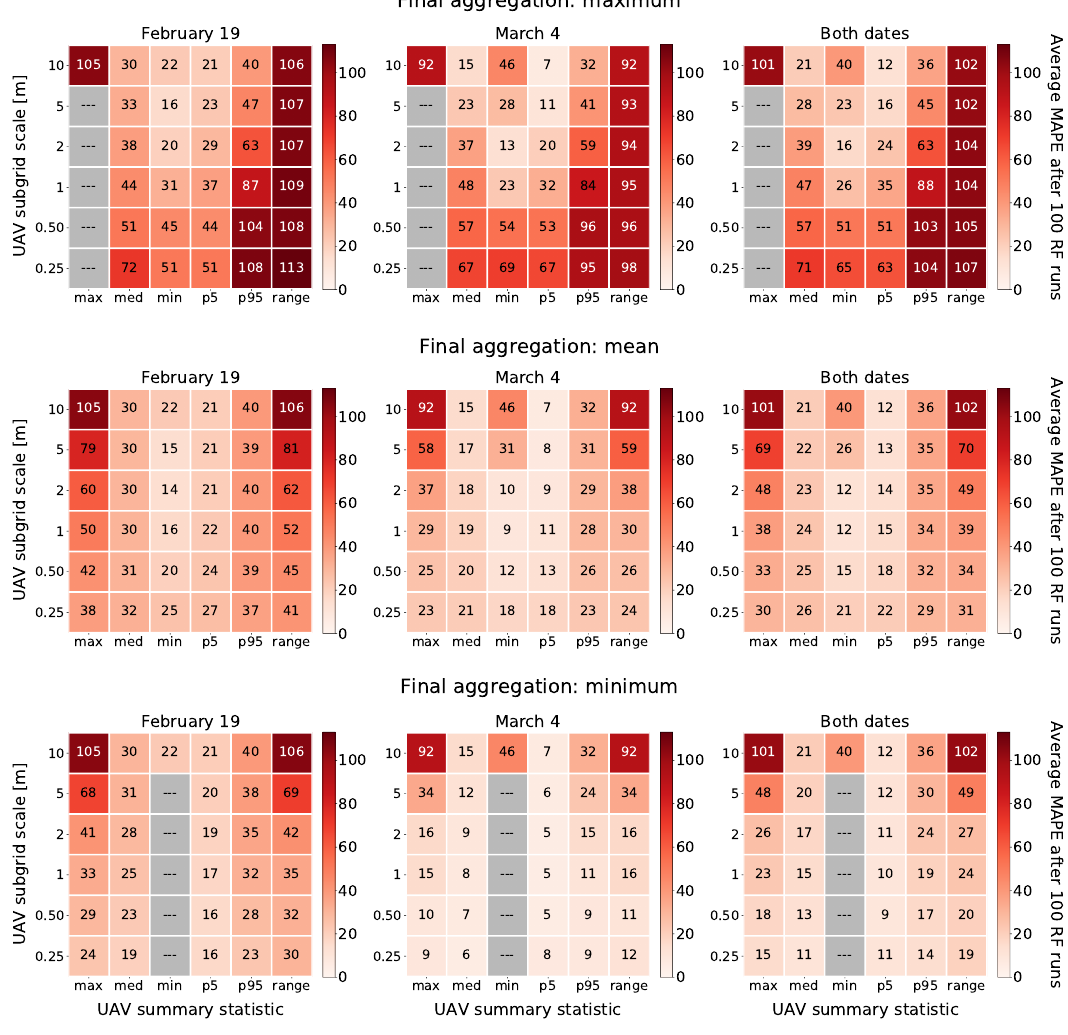
max med min p5 p95 range UAV summary statistic Figure 10. Mean absolute percentage error (MAPE) for RF regression targets for RF models trained with input data sets with samples from 19 February only ( left column ), 4 March only ( middle column ), and both survey dates combined ( right column ). Each grid cell represents a target surface roughness metric calculated using a particular statistic (x-axes) and subgrid spatial scale (y-axes). The final operations applied to aggregate the subgrid roughness metrics at the 10 m Sentinel-1 scale are the maximum ( top row ), mean ( middle row ), and minimum ( bottom row ). Values reported in grid cells are the average MAPE after 100 RF regression model runs. Grey cells indicate redundant model runs that were not conducted (see